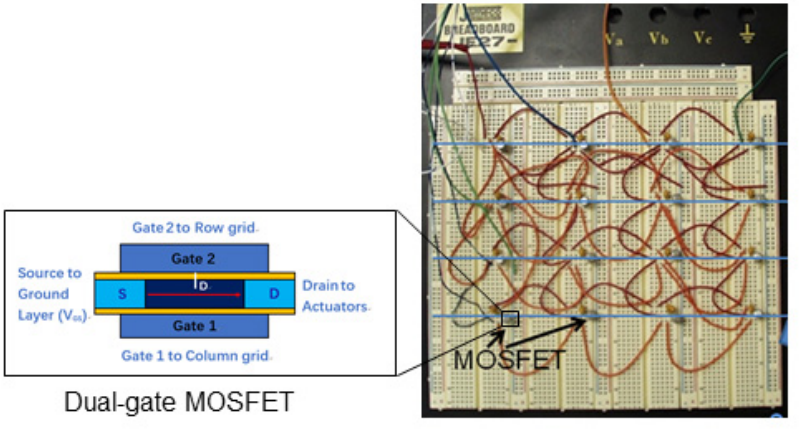
Figure 2. A breadboard layout of a 4×4 PD circuit system.